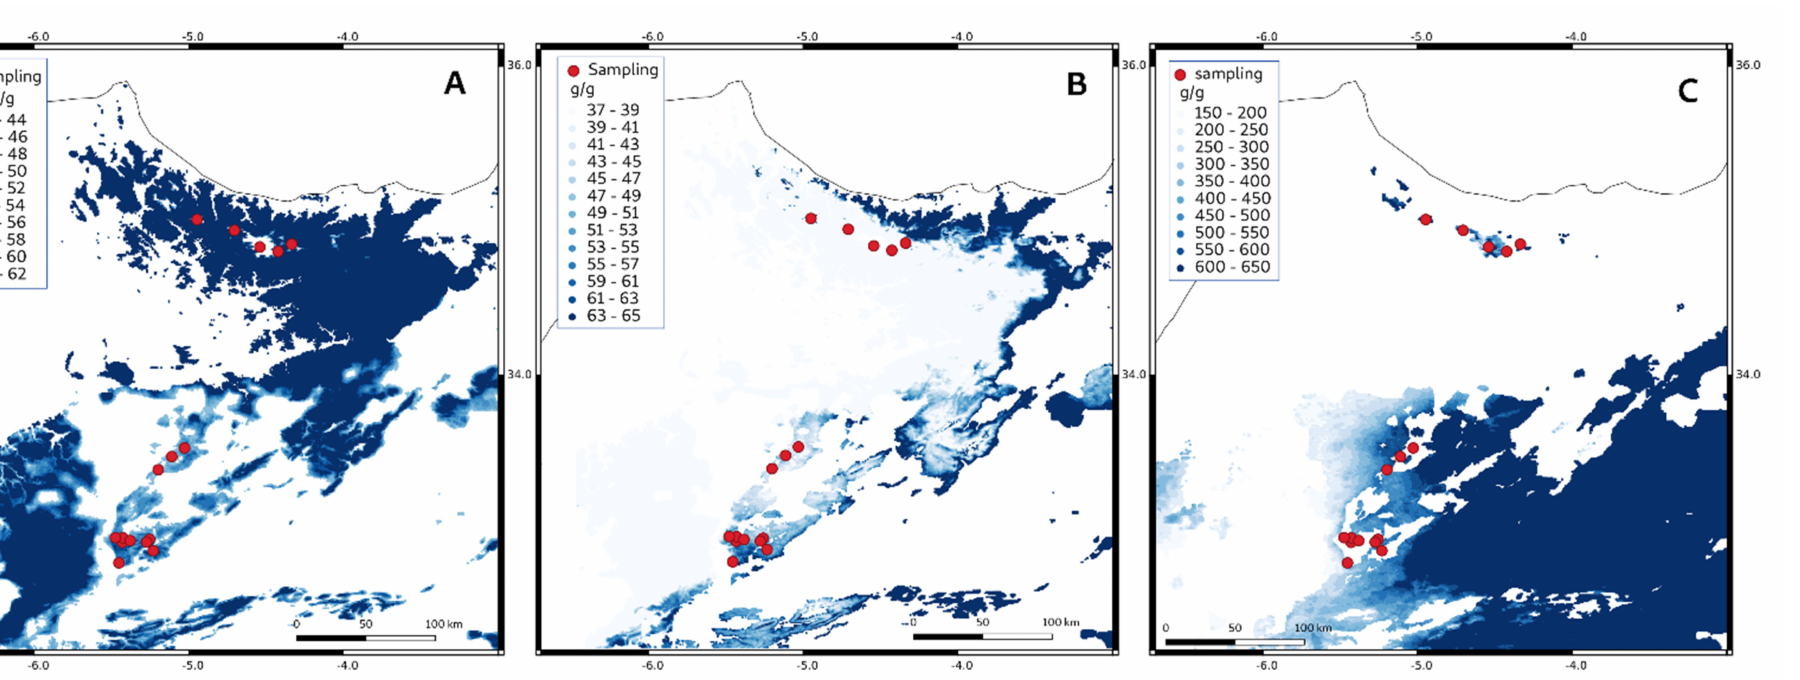
Figure 4. Examples of predicted distribution of the 3 traits (for 2016 growth year) over the study area with sampling locations (red dots). ( A ): specific leaf area, ( B ): leaf C:N, ( C ): sapwood